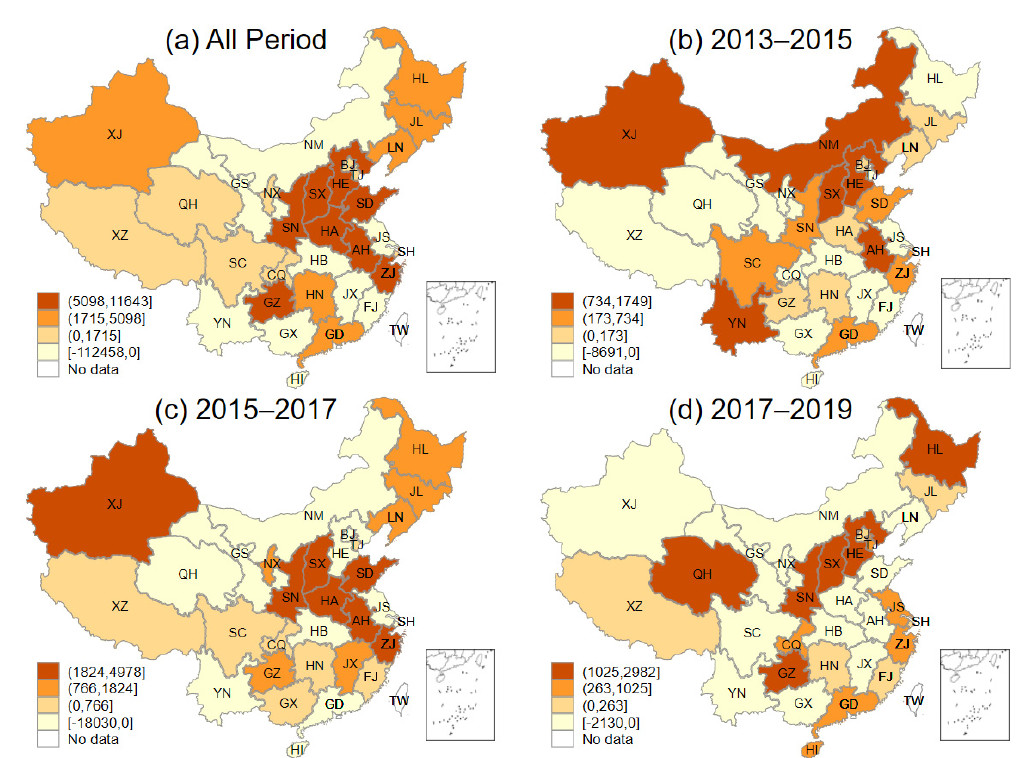
Figure 4. Region–Neighbor Solar PV Investment Competitive Effect Across China Regions: ( a ) all periods; ( b ) 2013–2015; ( c ) 2015–2017; ( d ) 2017–2019.